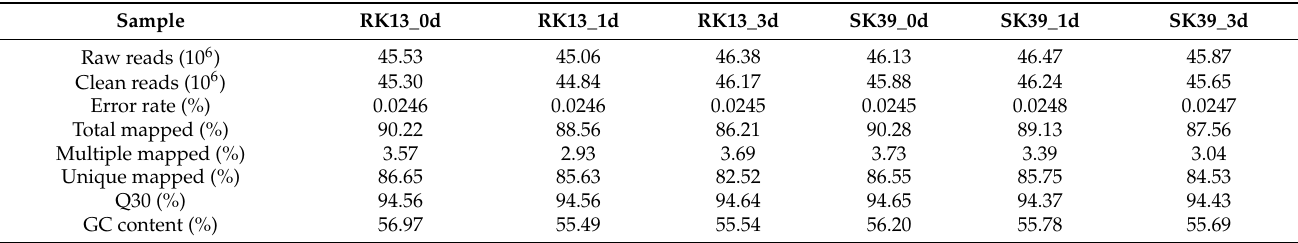
Table 1. Summary of mRNA sequencing